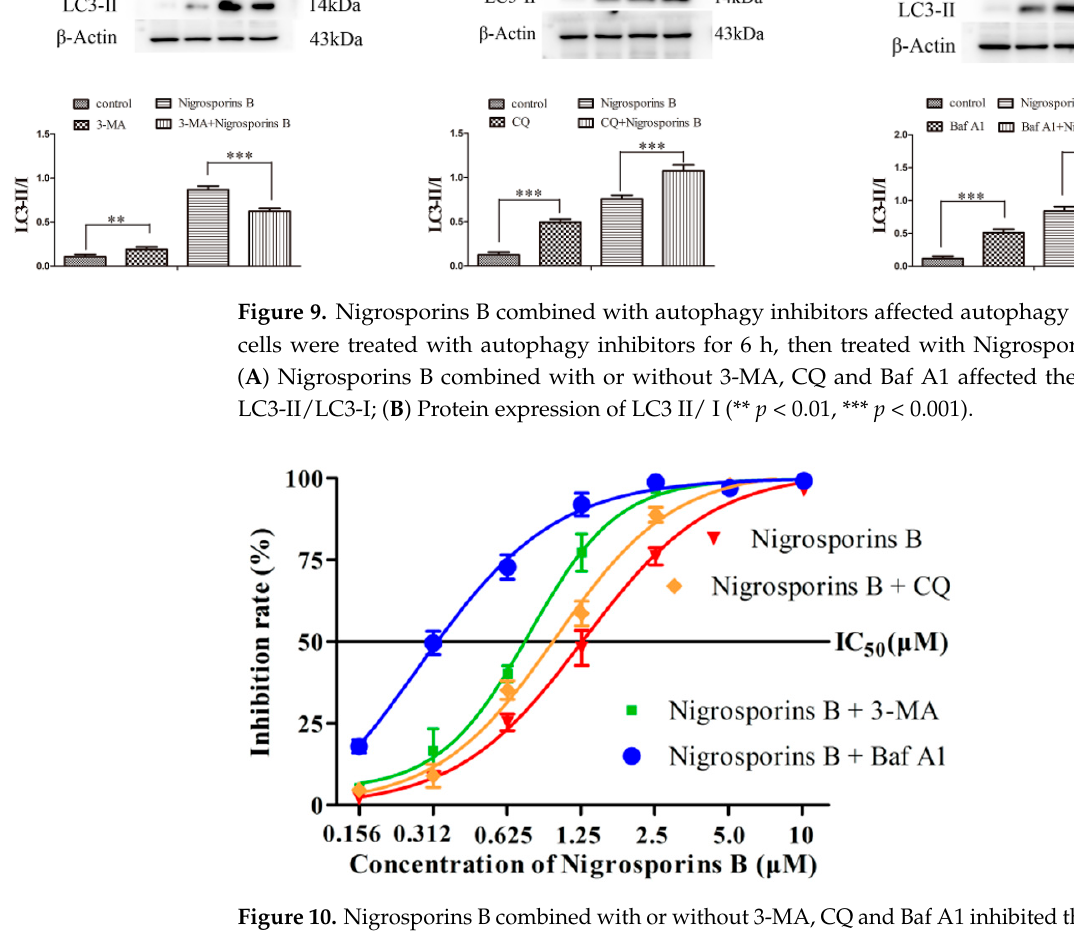
Figure 11. Nigrosporins B affected the expression of proteins of PI3K/AKT/mTOR signaling path- way in Ca Ski cells, cells were treated with Nigrosporins B for 24 h. ( A ) Representative western blotting bands of PI3K, Akt, mTOR, p-PI3K, p-Akt, p-mTOR, AMPK α , p-AMPK α and PTEN; ( B ) and ( C ) Protein expression of PI3K, Akt, mTOR, p-PI3K, p-Akt, p-mTOR, AMPK α , p-AMPK α and PTEN (* p < 0.05, ** p < 0.01, *** p < 0.001).